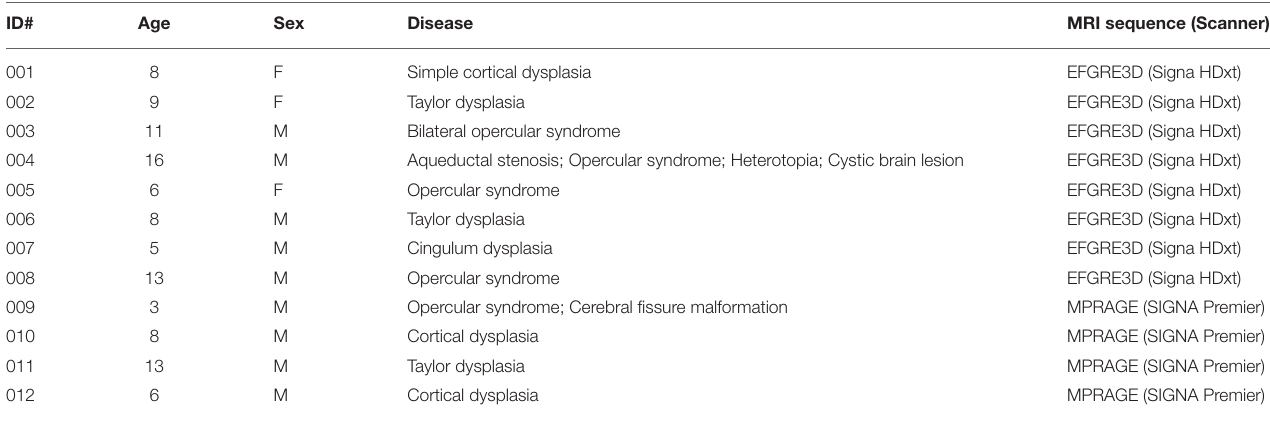
TABLE 1 | Demographic data of the pediatric dataset used for the clinical evaluation of the